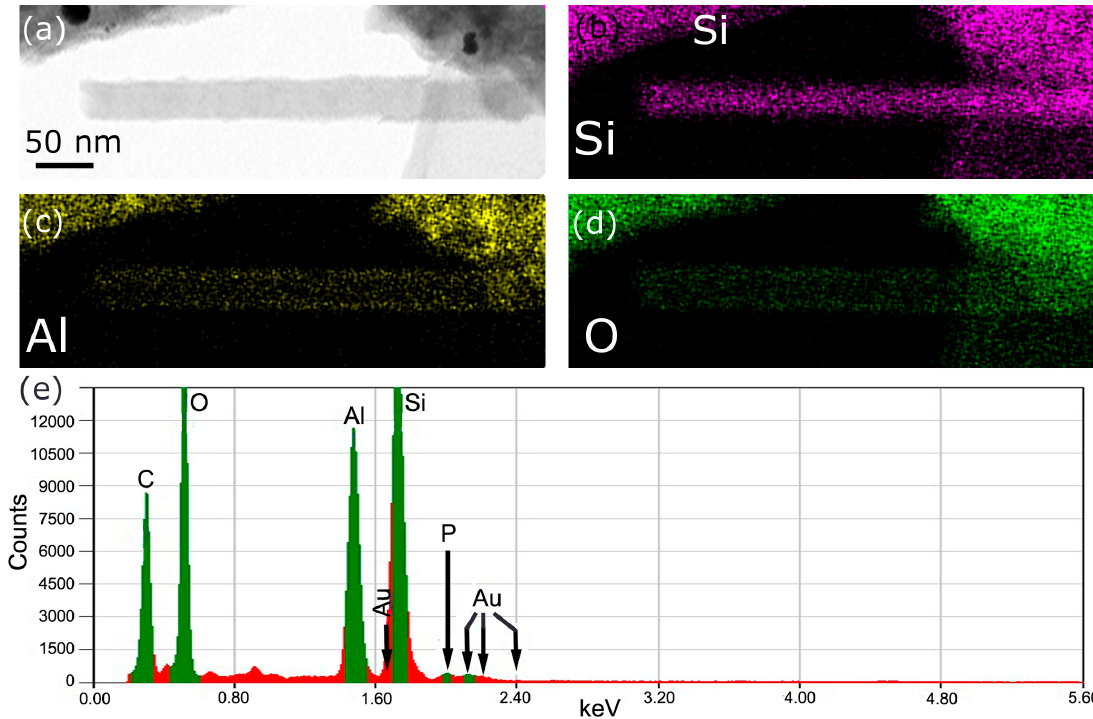
Figure 4. Chemical mapping and quantitative analysis of the elements by STEM EDS of an Al 2 O 3 passivated Si NN FET after GOPS-based functionalization process. ( a ) Bright field TEM micrograph of a Si NW passivated with Al 2 O 3 . ( b ) Silicon map. ( c ) Aluminum map. ( d ) Oxygen map. ( e ) Quantitative analysis of the elements (Au in the results comes from residues of the metal contacts).